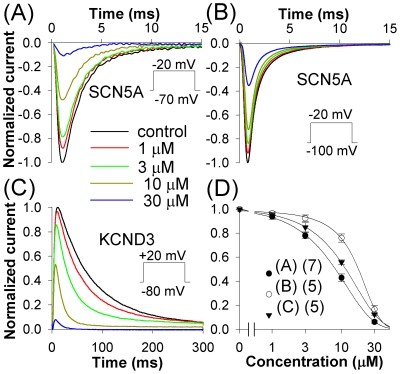
Effects of celecoxib on SCN5A and KCND3.(A–B) SCN5A currents were evoked by pulses to −20 mV from a HP of −70 mV (A) or −100 mV (B) in control and in the presence of different concentrations of celecoxib. (C) Inhibition of KCND3 channels. The currents were evoked by pulses to +20 mV from a HP of −80 mV. (D) Dose-response relations for inhibition of peak SCN5A and KCND3 currents; letters in the legend refer to the corresponding panels. A–C, legends are coded as in the panel A.